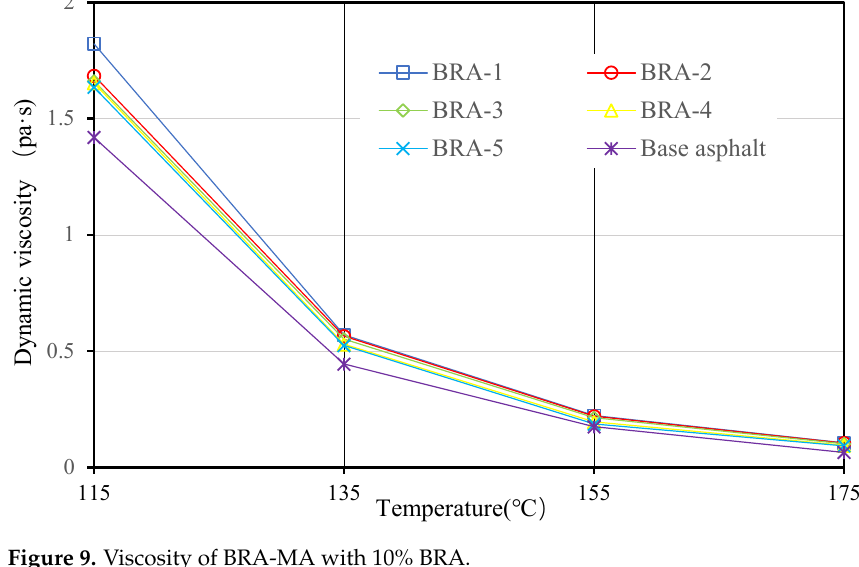
Figure 9. Viscosity of BRA-MA with 10% BRA.